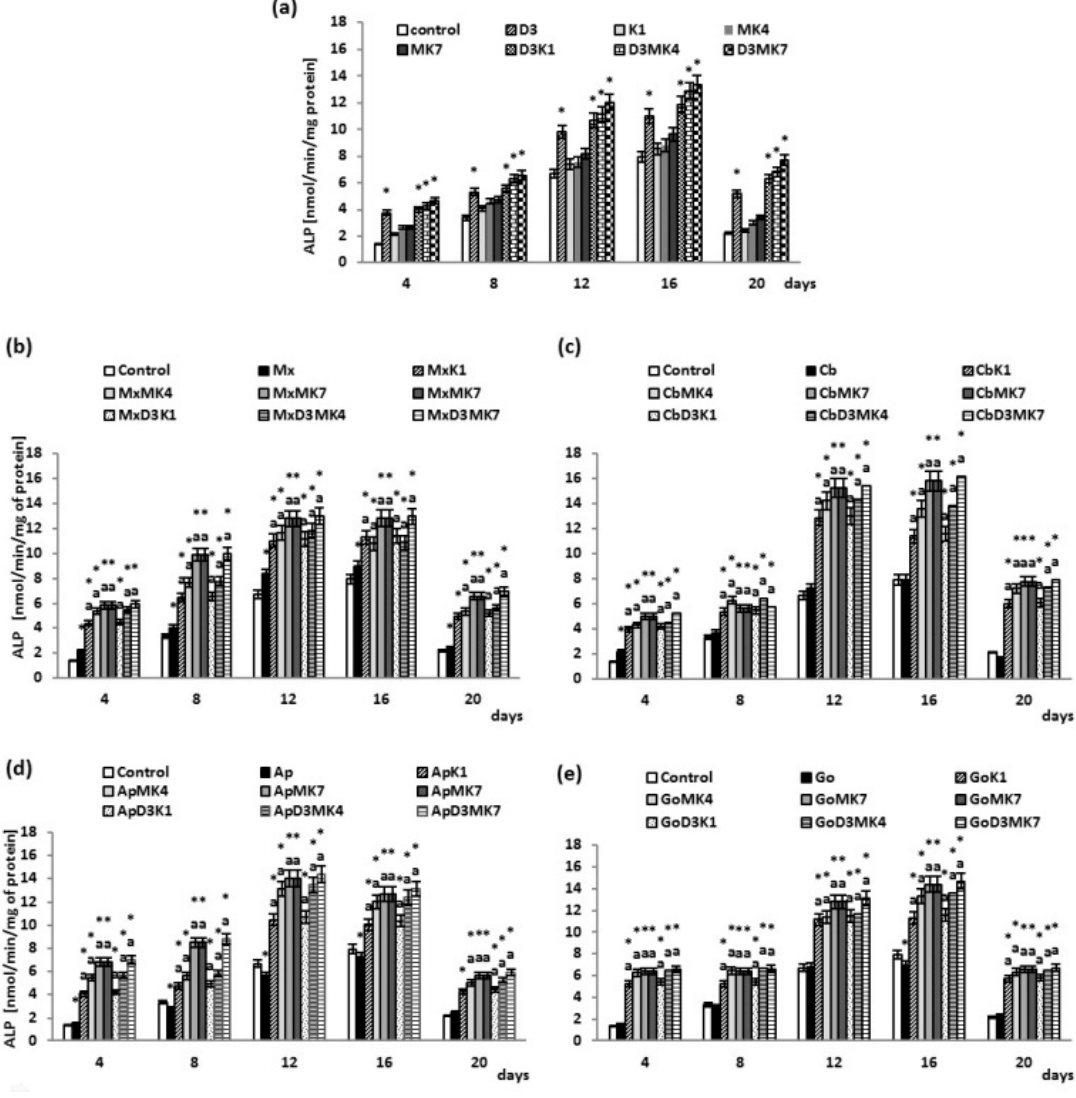
Figure 6. ALP activity in osteoblasts after incubation with hydroxyapatites and treated with vitamins D3, K1, MK4, and MK7 after 4, 8, 12, 16, and 20 days. The results are expressed as the nmol/min/mg of protein and are shown as the mean ± SD ( n = 5). The values for the control cells and the treated cells were significantly different according to unpaired Student’s t -test. * Statistically significant differences versus control, p < 0.05; ( a ) statistically significant differences versus hydroxyapatites (Mx (Maxgraft), Cb (Cerabone), Ap (Apatos), Go (Gen-Os), respectively for graphs ( b – e )), p < 0.05.